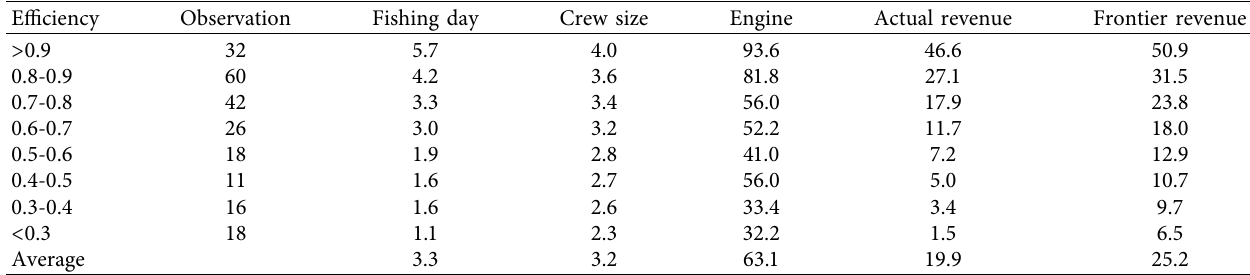
Figure 2: Frequency distribution of technical efciencies for the trawling in the Mekong Delta. Table 4: Inputs, actual revenue, and frontier revenue at diferent